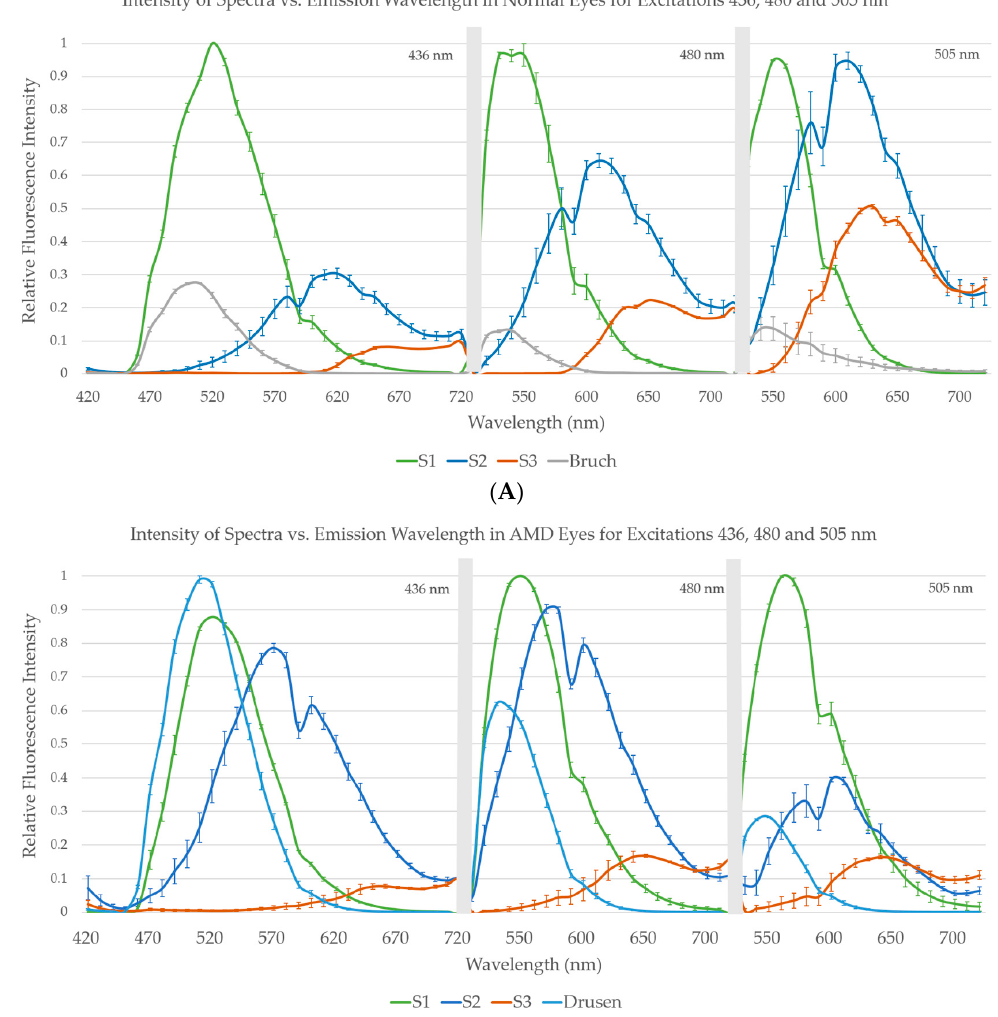
Figure 5. Mean spectra from 10 normal and 10 AMD eyes from three wavelength excitation AF. ( A ) Mean spectra from 10 normal eyes. Bruch’s membrane, S1, S2, and S3 mean emission spectra at excitations 436 nm, 480 nm, and 505 nm are plotted with standard error bars, normalized to the maximum emission for each excitation. Spectral amplitudes from each contributing tissue are proportional to the total emissions of the respective spectra from that tissue. Hence the spectral amplitudes shown here are proportional to the mean total emissions from all 10 tissues. ( B ) Mean spectra from 10 AMD eyes. SDr from drusen, S1, S2, and S3 mean emission spectra at excitations 436 nm, 480 nm, and 505 nm are plotted with standard error bars, normalized to the maximum emission for each excitation. BrM spectrum is less visible than in normal eyes, above.